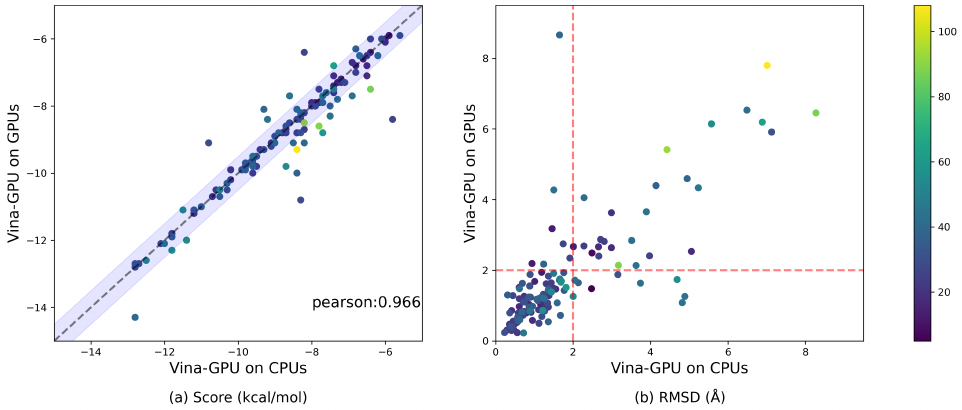
Figure 11. Comparable docking accuracy by the implementation of Vina-GPU on CPUs. All 140 com- plexes were used, and the color bar encodes the number of atoms in a ligand. A margin of 0.5 kcal/mol difference on the docking score for the implementation of Vina-GPU on CPUs or GPUs is highlighted with lavender in ( a ). The Pearson correlation coefficient of their docking scores is 0.966 (indicated by “pearson”). The RMSD value that indicates an acceptable binding pose (<2 Å) is separated by a red dashed line in ( b